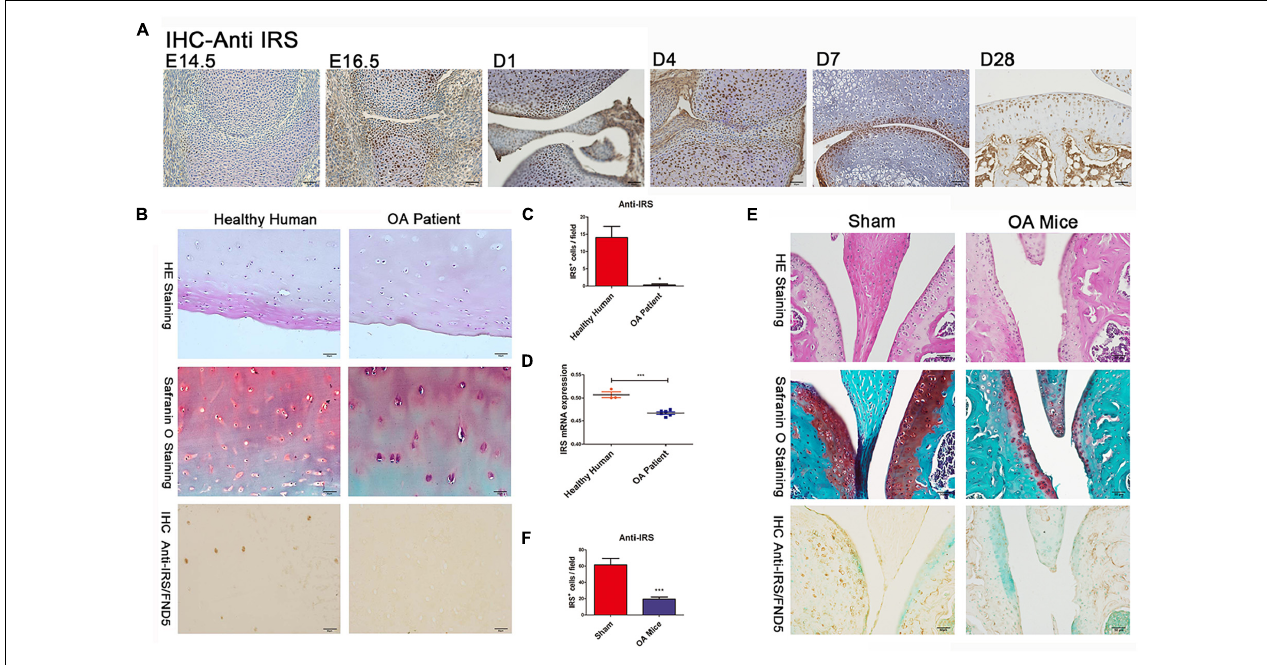
FIGURE 1 | Irisin is involved in chondrogenesis and osteoarthritis (OA). (A) IHC shows irisin expression in cartilage cells at different developmental stages with distinct differential patterns (C57BL/6J wide type mice, n = 6). (B,C) The articular cartilage of OA patients ( n = 6) showed a decreased expression of irisin (hematoxylin and eosin staining, Safranin-O staining, and immunohistochemical analyses). (D) Cartilage of OA patients ( n = 6) exhibits decreased irisin mRNA expression compared with healthy humans ( n = 3). (E,F) The articular cartilage of OA mice showed a decreased expression of irisin (C57BL/6J wide type mice with ACLT-model, n = 6). * p < 0.05, *** p <